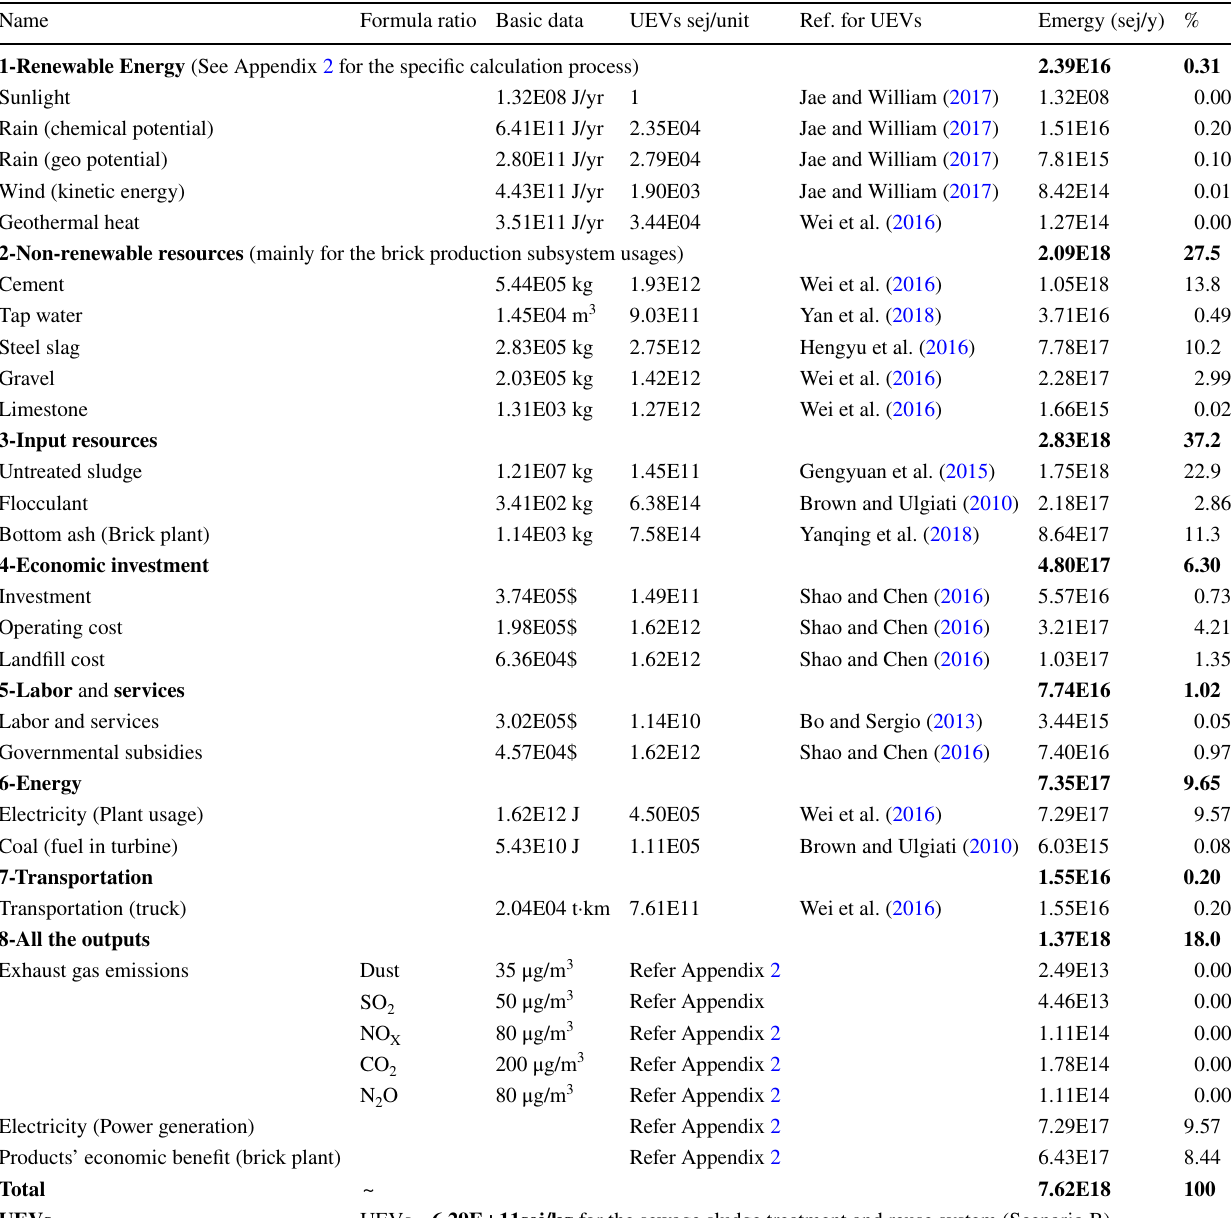
Table 6 Emergy calculated details of improved sludge treatment process (Scenario